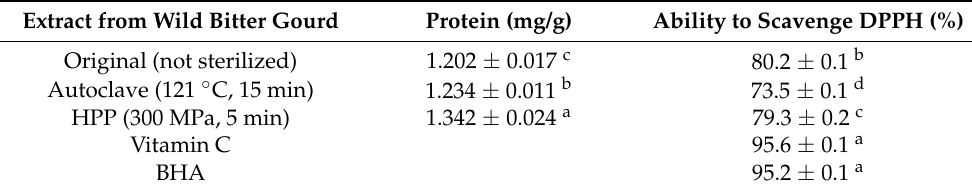
Table 2. Effect of different sterilization methods on total protein and antioxidant activity of extracts from wild bitter gourd. Extract from Wild Bitter Gourd Protein (mg/g)